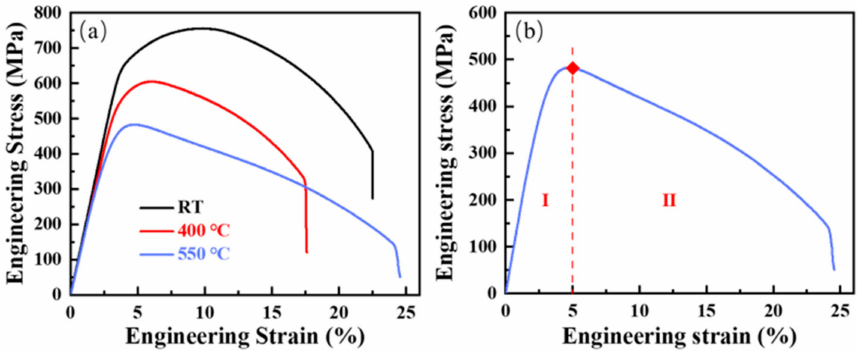
Figure 3. Engineering stress–strain curve of ( a ) 9Cr-F/M steel at constant RT, 400 ◦ C and 550 ◦ C, and ( b ) engineering stress–strain curve with two stages of 9Cr-F/M steel at 550 ◦ C.